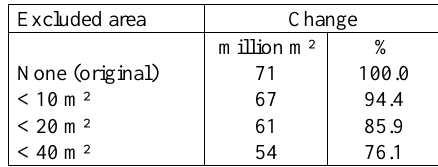
Table 2. Effect of small objects in North-Rhine-Westphalia (2012 to 2016)